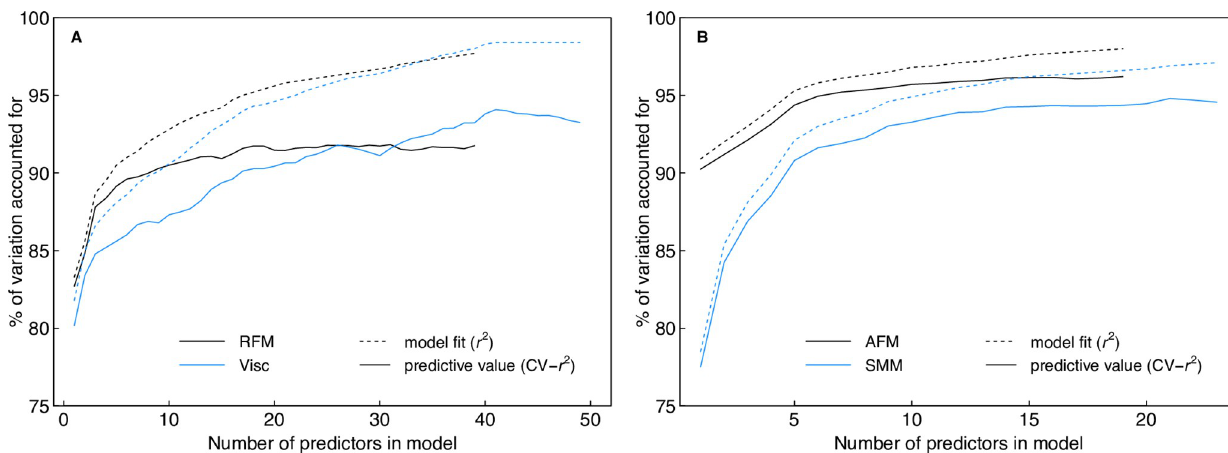
Fig 3. Increase in model fit (r-squared) and predictive value (cross-validated r-squared) with increasing number of predictors in the model. Predictors were included in a stepwise forward selection procedure to minimize the AIC. Curves illustrate how many predictors were needed to obtain the maximal predictive value and the moderate degree of overfitting (difference between r 2 and cross-validated r 2 ) found even with multiple predictors.